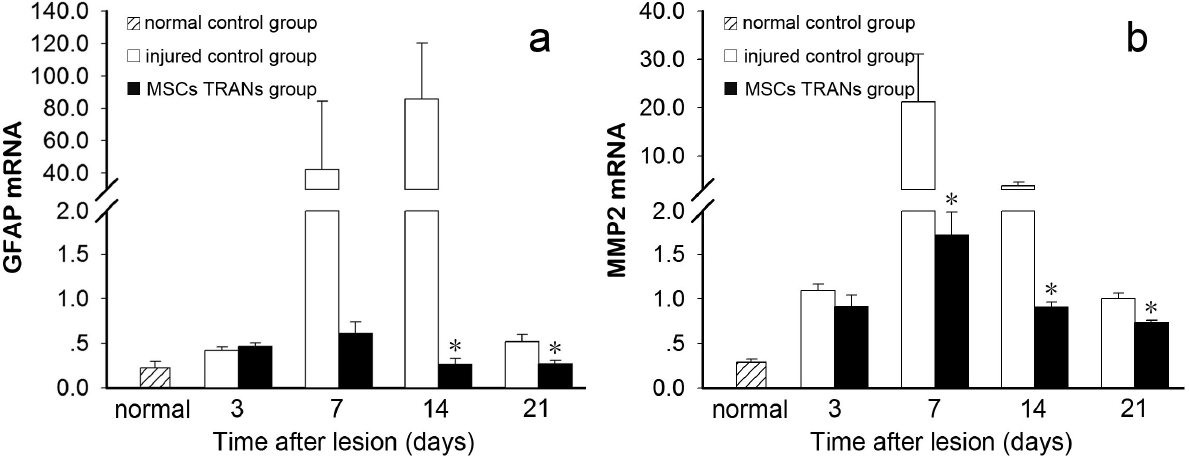
Figure 4. mRNA expression of GFAP and MMP-2 in laser-injured eyes. A parabolic change in GFAP ( a ) and MMP-2 ( b ) mRNA expression was found over time after laser injury. Asterisks denote significant differences between the injured control and MSC-treated groups (*, p <